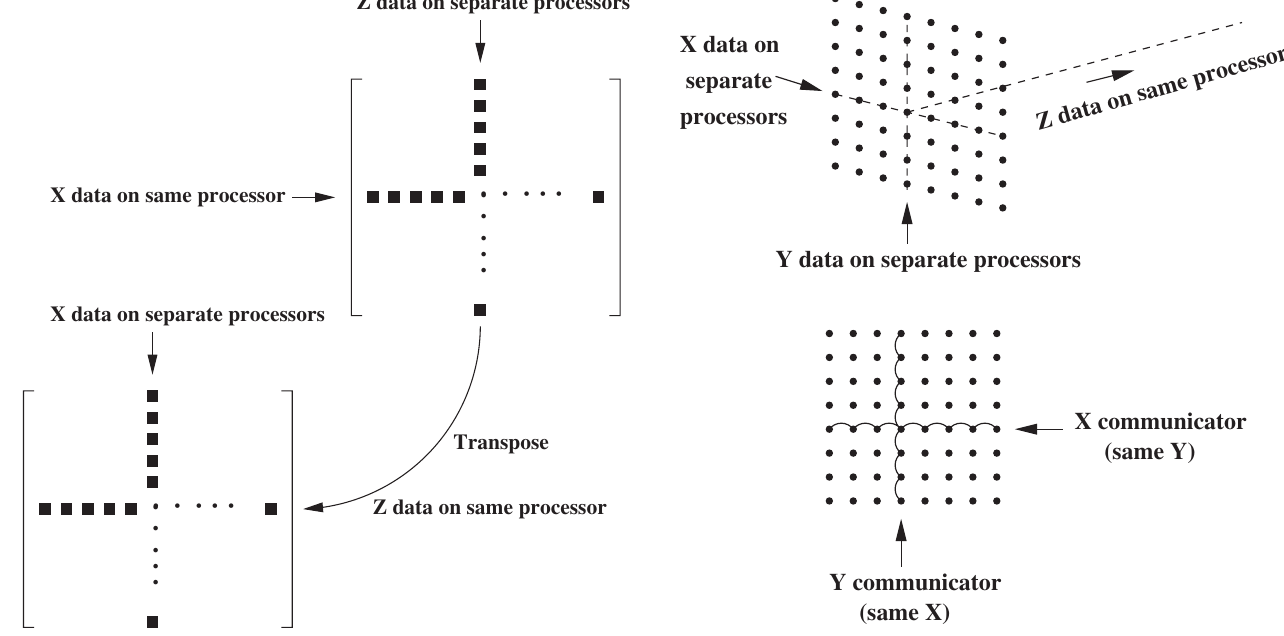
FIG. 1. Transposition of the SC data in the (cid:6) x; z (cid:7) plane repre- sented by a simple transposition of a 2D matrix. After trans- position the Z data for a given X originally shared among N processor will be on the same processor, so a FFT in the Z direction is easily